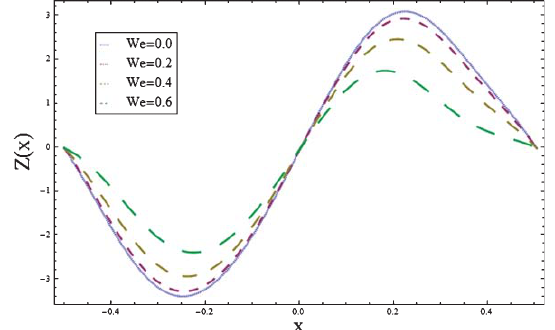
Fig. 12. Plot showing Z ( x ) versus x . Here a = 0 . 3, b = 0 . 5, d = 1, φ = π/ 4, (cid:14) = 1 . 5, Br = 2, Bi